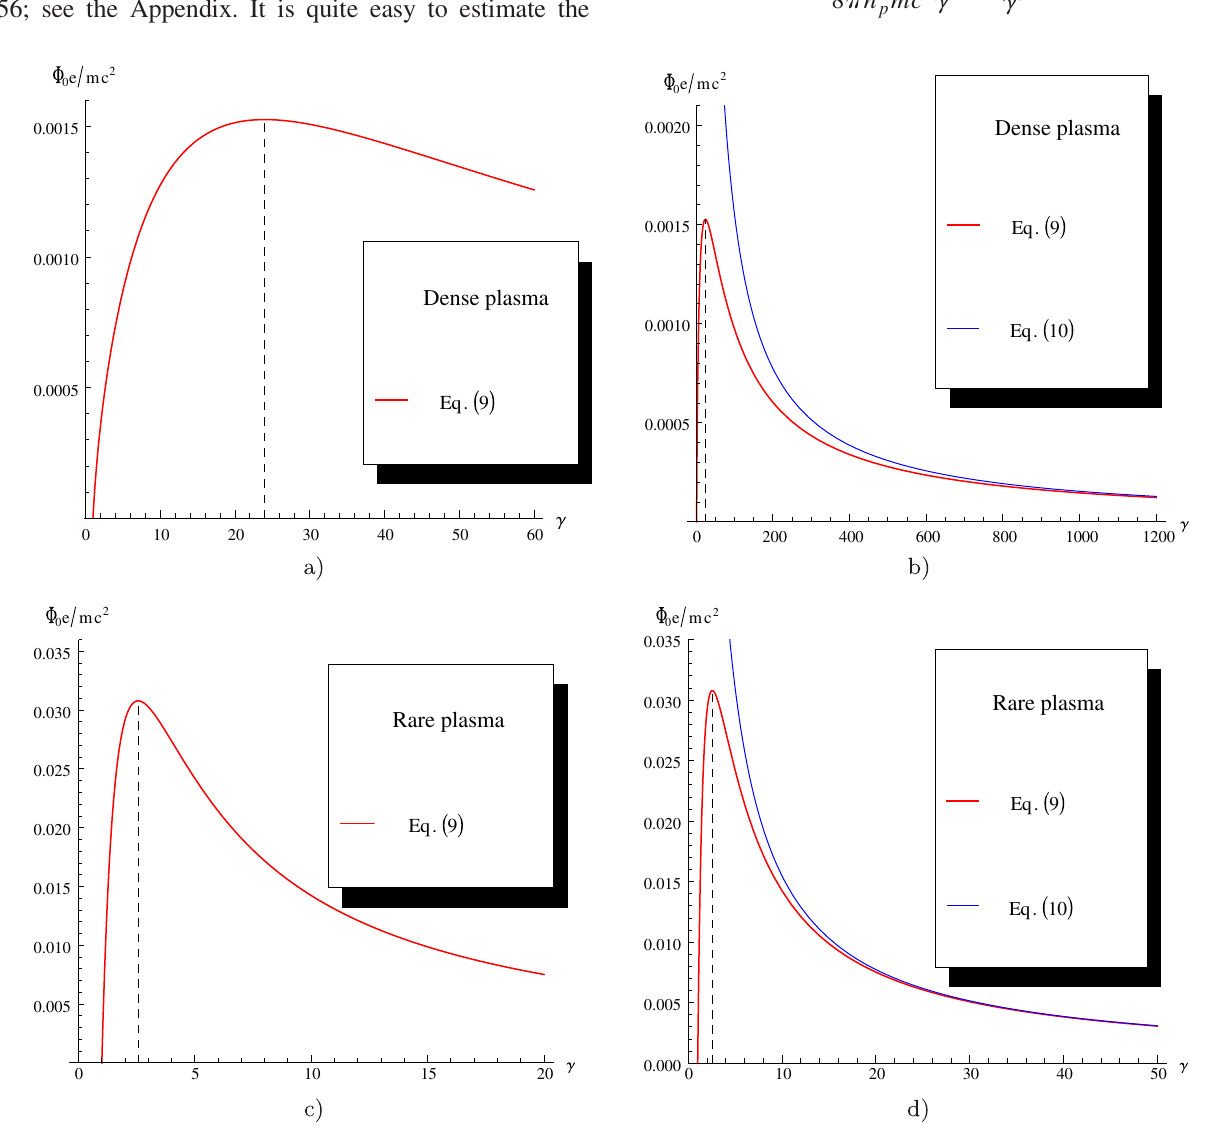
FIG. 1. (a) The relative stationary saturation amplitude of the plasma wake potential generated by the ultrarelativistic electron bunch Eq. (9) for (a), (b) dense (5) at n b ¼ 2 (cid:8) 10 12 cm (cid:1) 3 , n p ¼ 10 16 cm (cid:1) 3 , (cid:1) 0 ¼ 24 and (c), (d) rare (6) plasmas at n b ¼ 2 (cid:8) 10 12 cm (cid:1) 3 , n 6 (cid:8) 10 12 cm (cid:1) 3 , (cid:1) 2 : 6 . In (b) and (d) the relative stationary saturation amplitude in the ultrarelativistic limit (10) is presented p ¼ 0 ¼ for